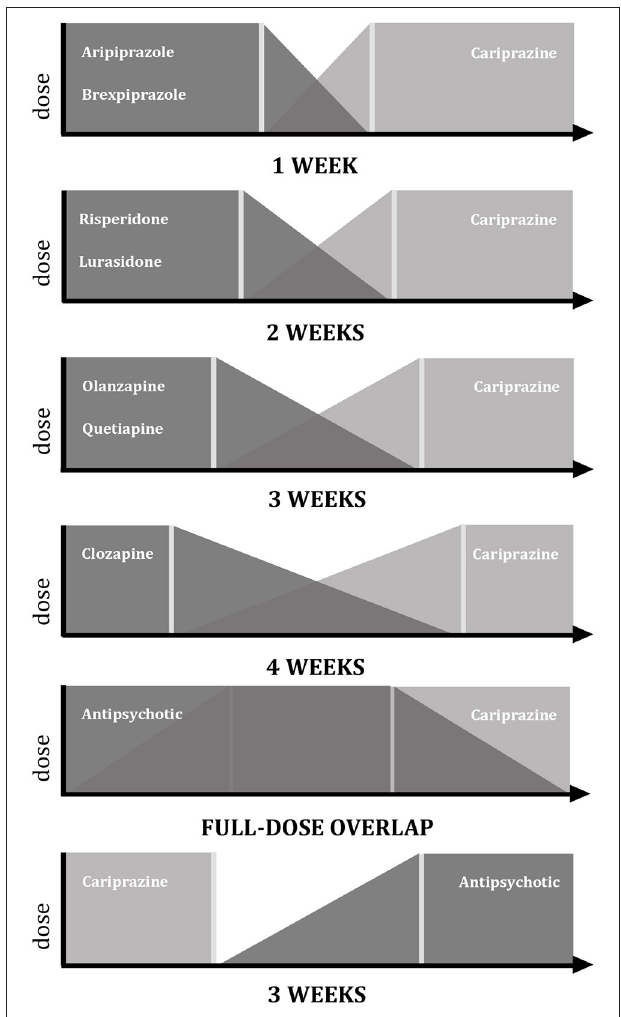
FIGURE 1 | Switching strategies with cariprazine. Graphic representation of data according to Németh et al. ( 7), Fagiolini et al. (45), Sullivan et al. (46), Stephen (